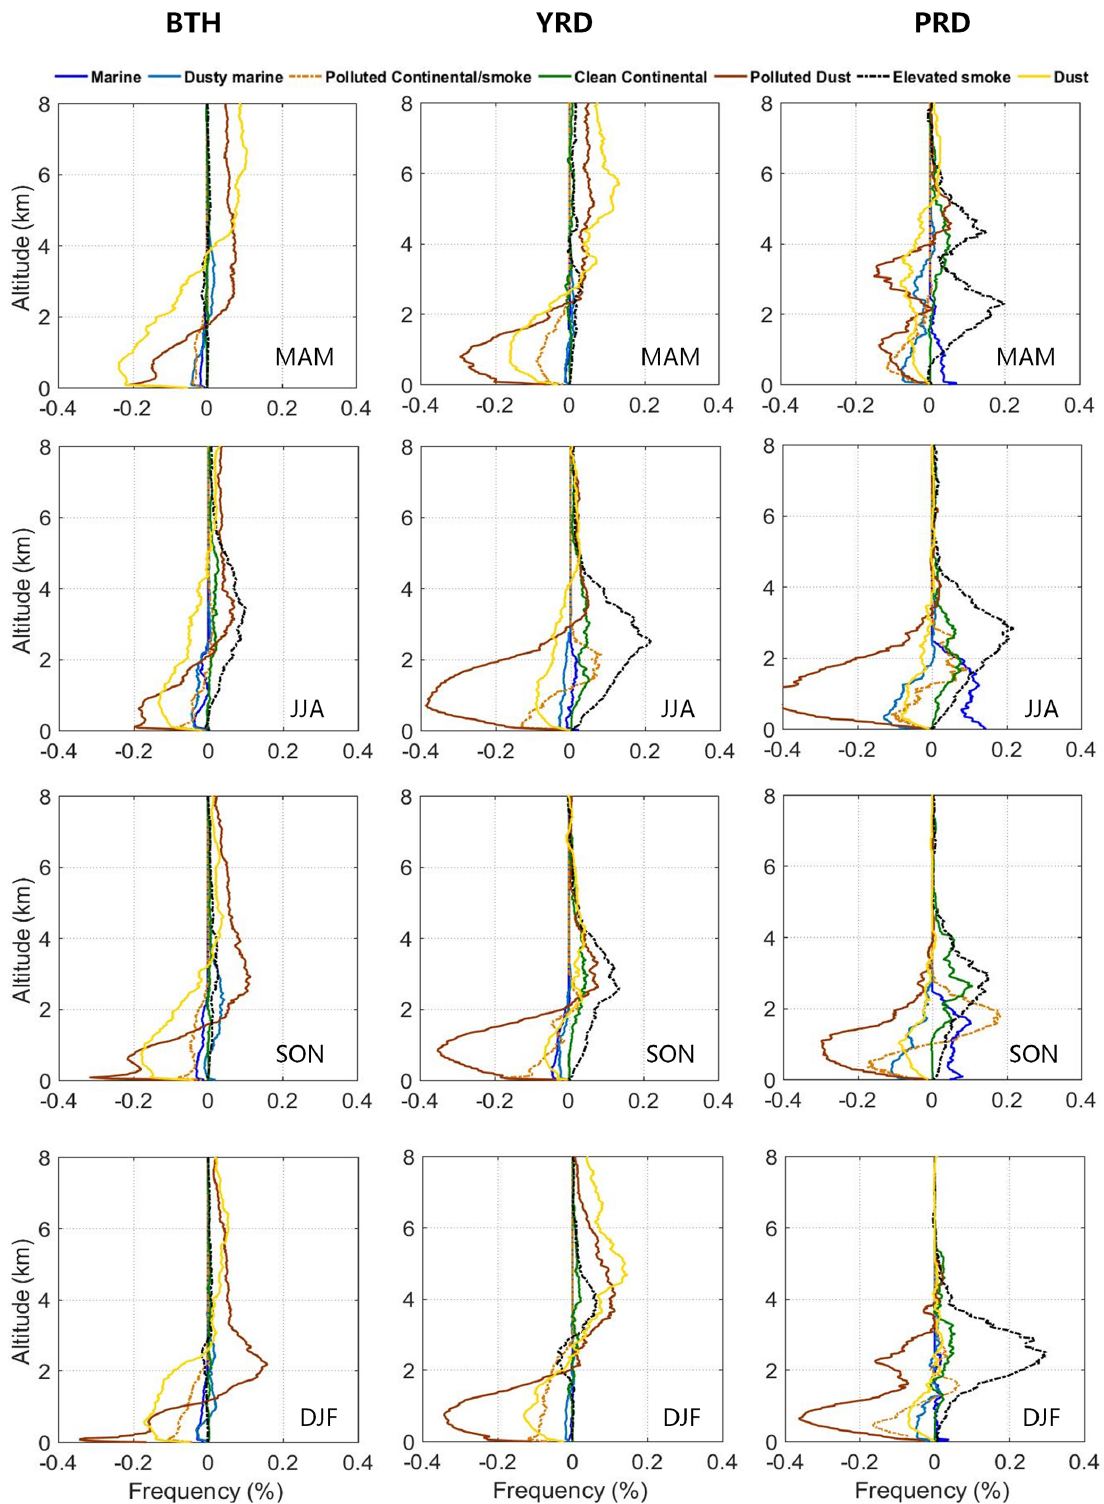
Figure 11. Differences between nighttime and daytime vertical distributions of the FO of CALIOP-derived aerosol types (see legend) (nighttime minus daytime) by season, averaged over the years 2007–2020, over the BTH (left), YRD (middle) and PRD (right).